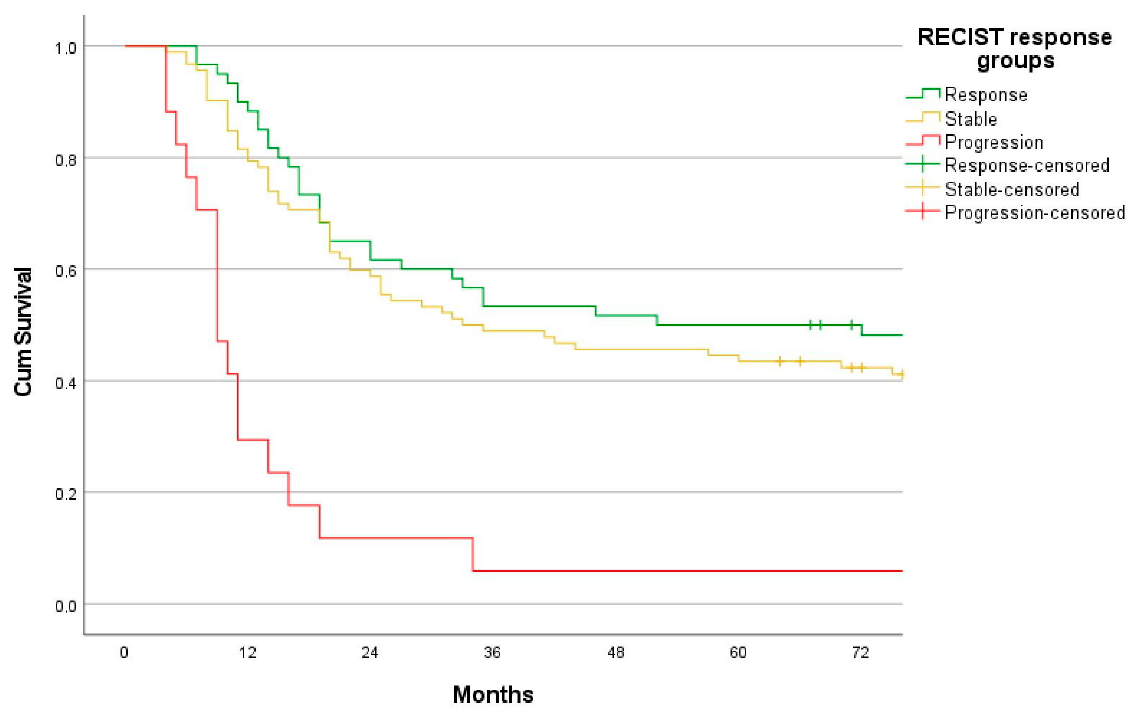
Figure 1. Overall survival stratified on the basis of the RECIST response mode, n = 169. Response ( n = 60), stable disease ( n = 92), and progression ( n = 17). Response vs. stable disease log-rank p = 0.570.